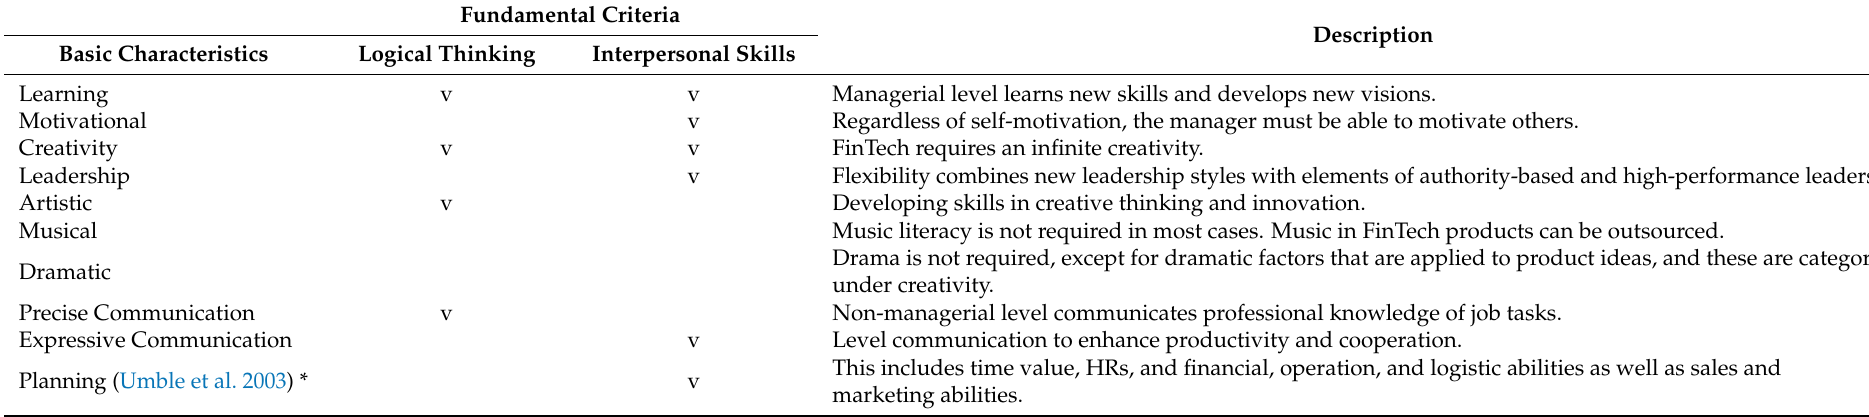
Table 2. Comprehensive criteria for a FinTech